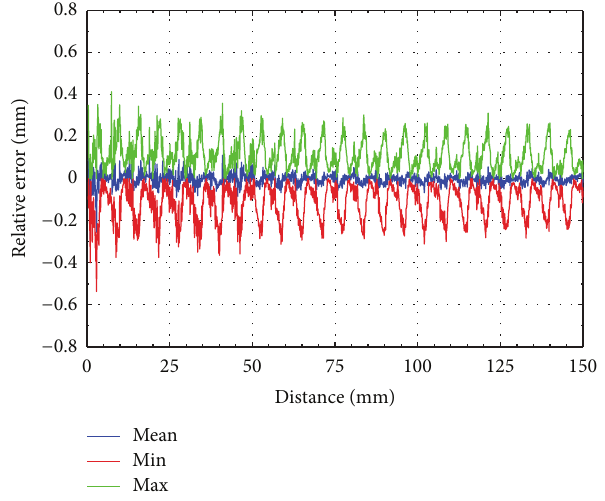
Figure 19: Relative measurement error.